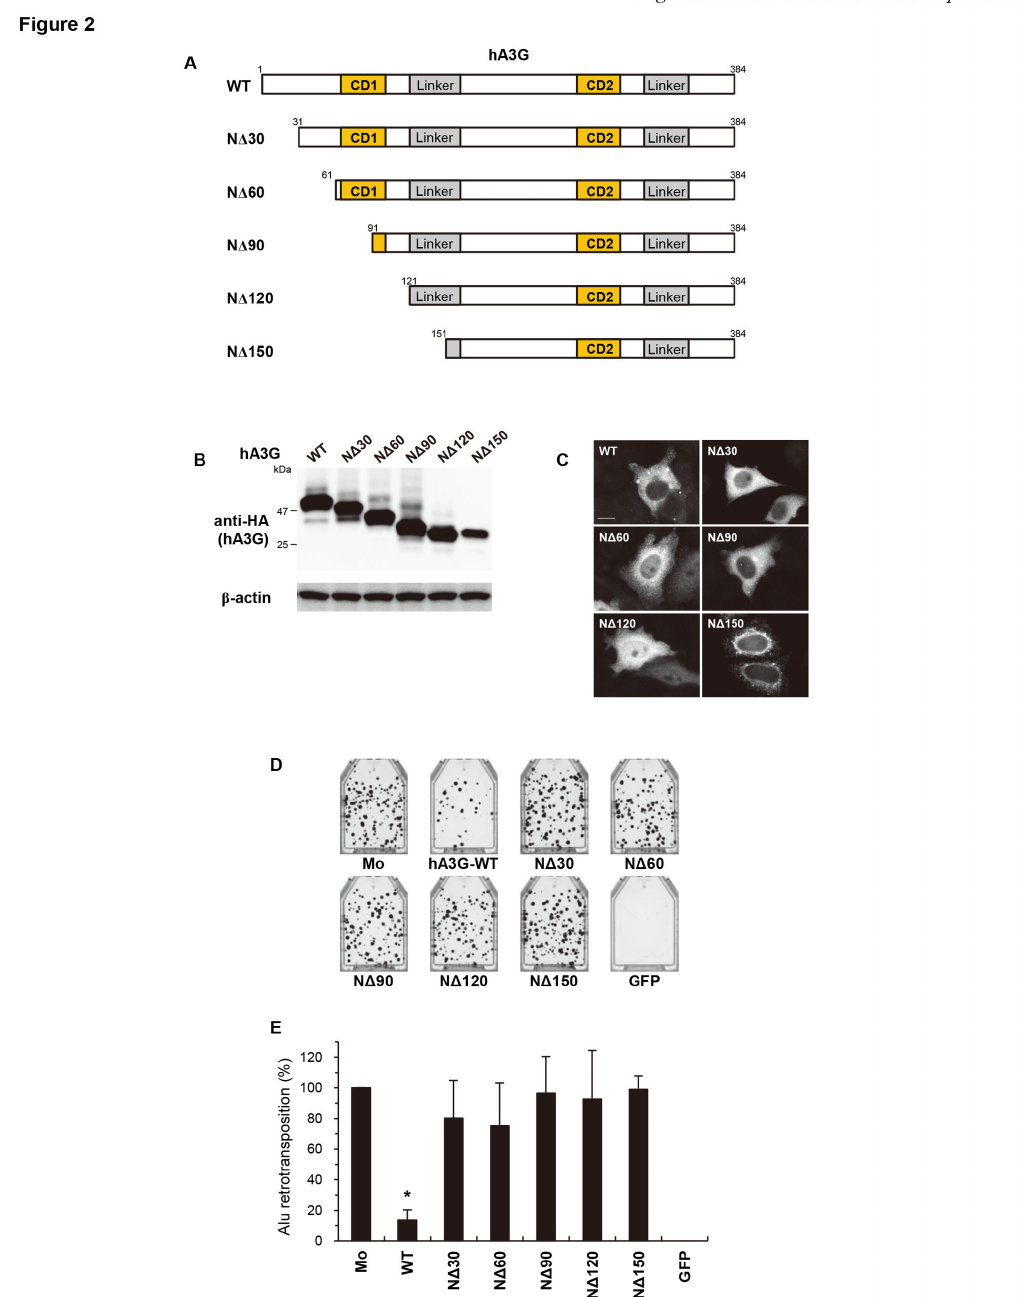
Figure 2. The N-terminal 30 amino acids regulate the anti-Alu activity of hA3G. ( A ) Schematic depiction of a series of N- terminal deletion mutants of hA3G. CD1, N-terminal cytidine deaminase; CD2, C-terminal cytidine deaminase. ( B ) Western blot analysis was performed using extracts from 293T cells transfected with plasmids expressing HA-tagged hA3G mutant proteins. Monoclonal antibodies specific for HA (upper) or β-actin (lower) were used. ( C ) Representative images of HeLa cells transfected with the indicated plasmids are shown. hA3G wild-type (WT), NΔ30, NΔ60, NΔ90, and NΔ120 mutant proteins were predominantly localized to the cytoplasm, whereas NΔ150 mutant protein localized to the perinuclear region. Scale bar: 20 µm. ( D , E ) An Alu retrotransposition assay was performed as described in Figure 1. Crystal violet-stained G418 R colonies were counted to determine the level of Alu retrotransposition. The data shown are the mean ± SD of triplicate experiments. Mo, mock; WT, wild-type hA3G; GFP, GFP only. * P < 0.005, t -test. doi: 10.1371/journal.pone.0084228.g002 PLOS ONE |